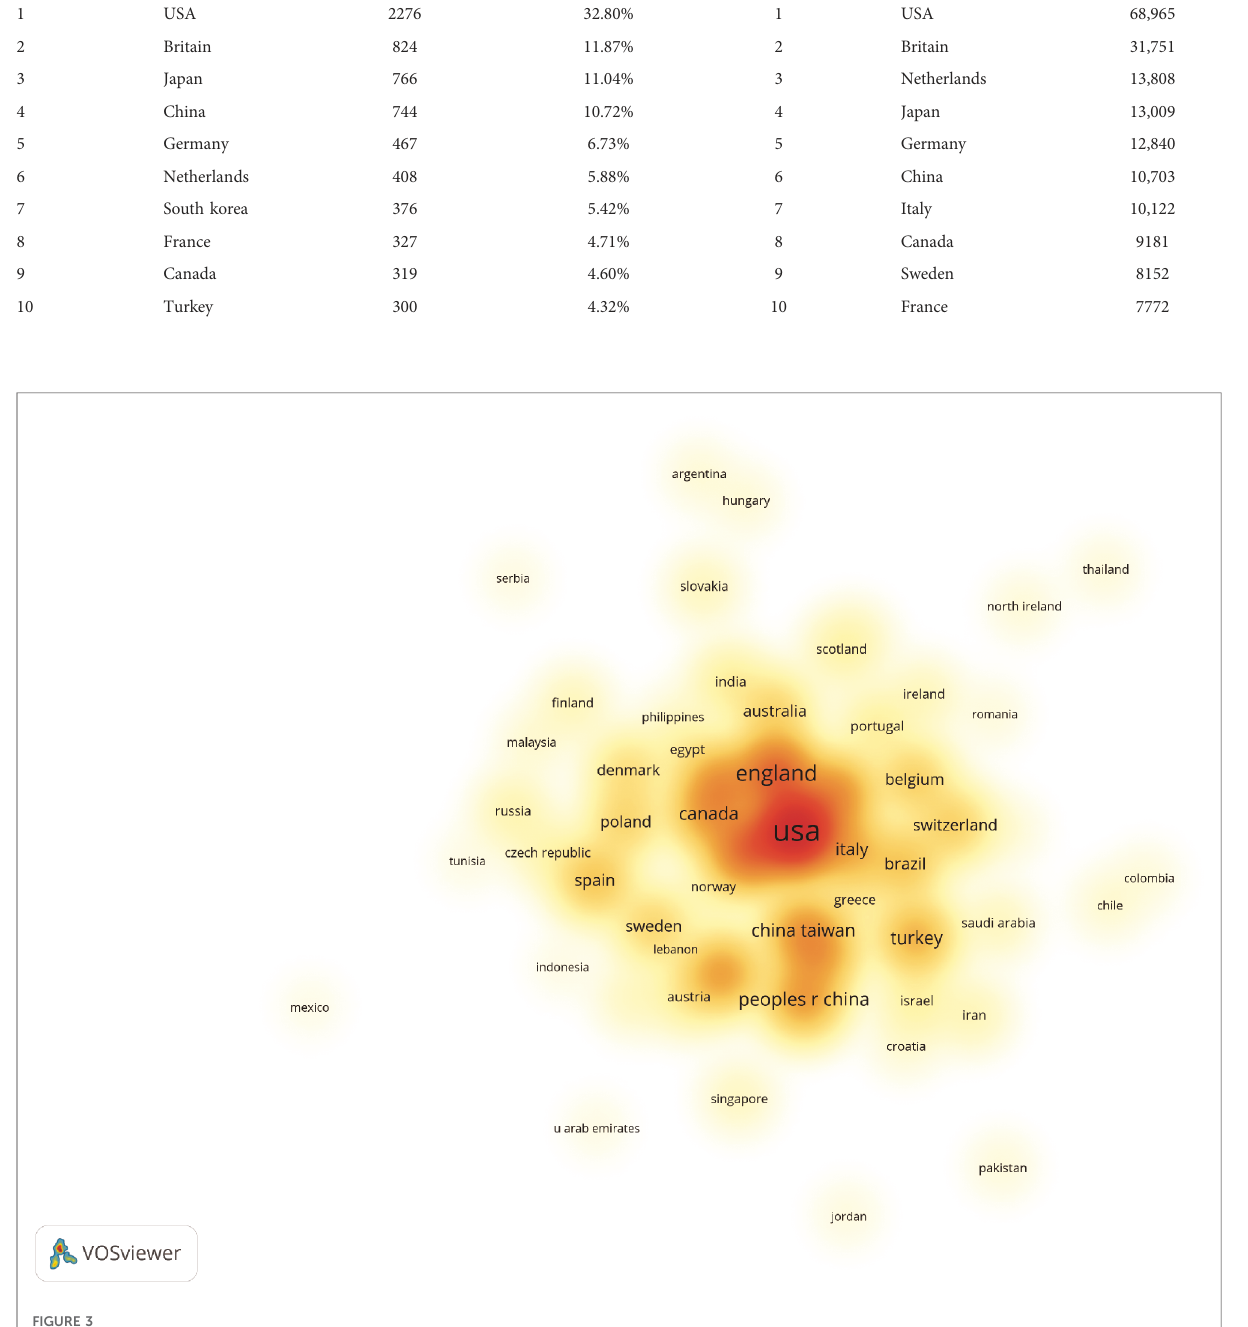
FIGURE 3 Network of institutions visualized in VOSviewer; the size of circles reveals the number of publications in different